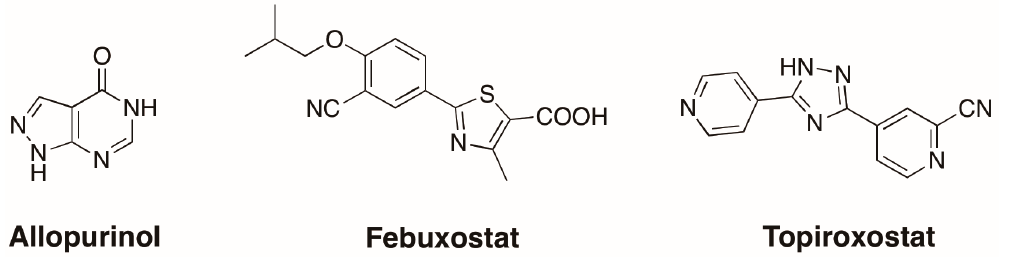
Figure 1. Chemical structures of approved XO inhibitors allopurinol, febuxostat (TEI-6720), topiroxostat (FYX-051).